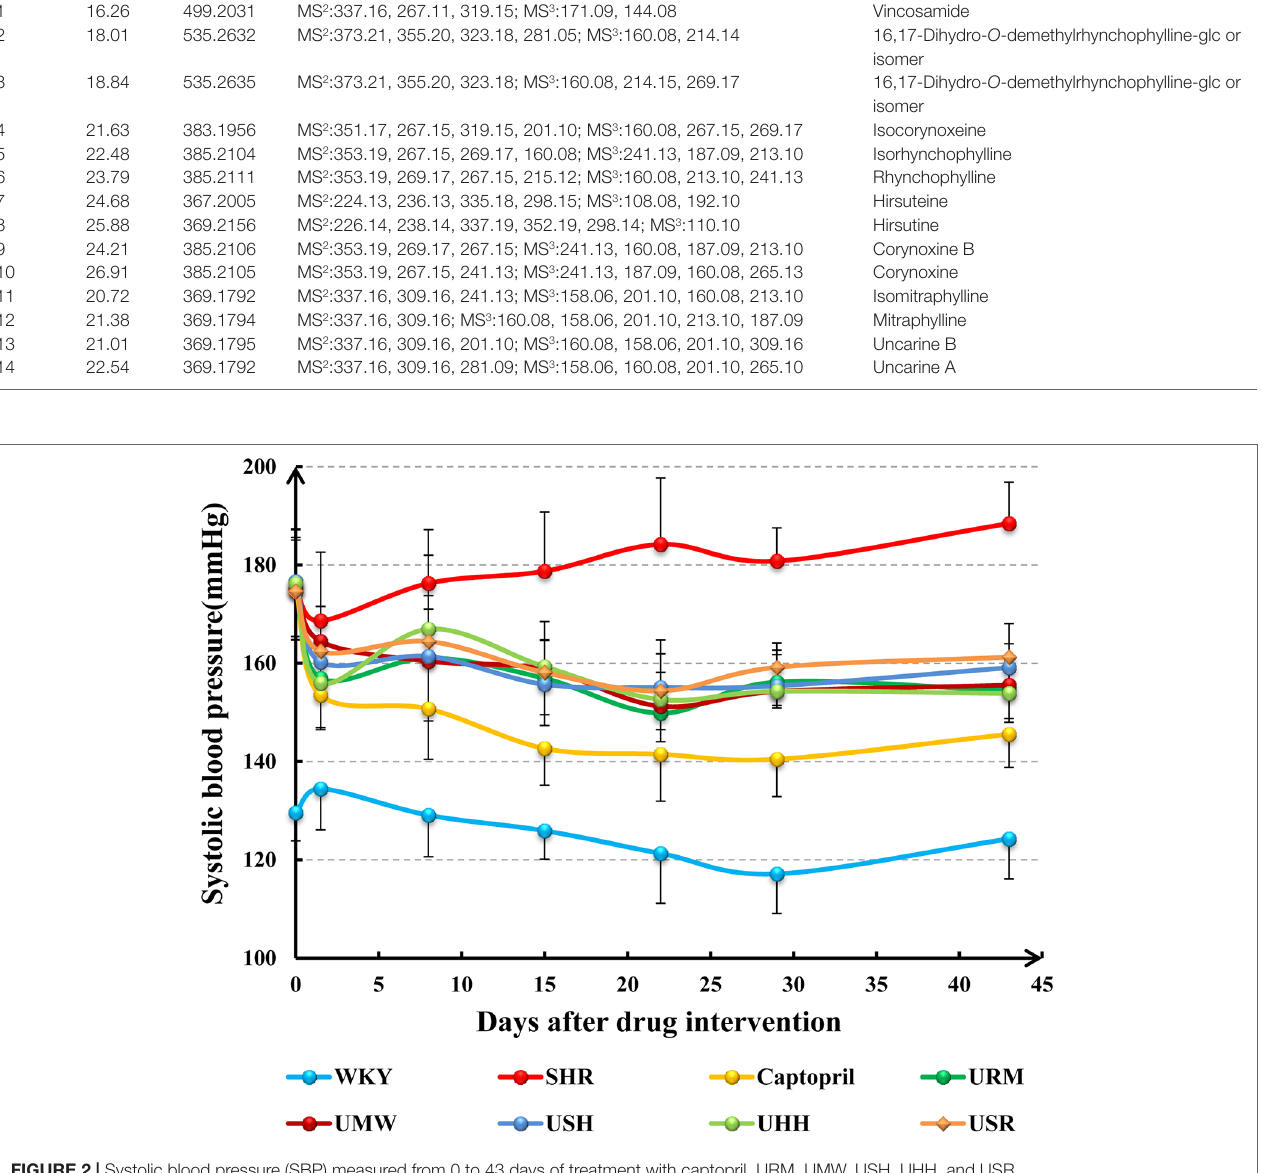
shown in Figure 4 . According to the O2PLS-DA algorithm, every dot represents a sample and contains information regarding all of the metabolites measured in the sample as well as their